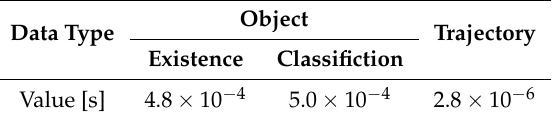
Table 1. Time consumptions of the proposed data fusion schemes for 10 data points.